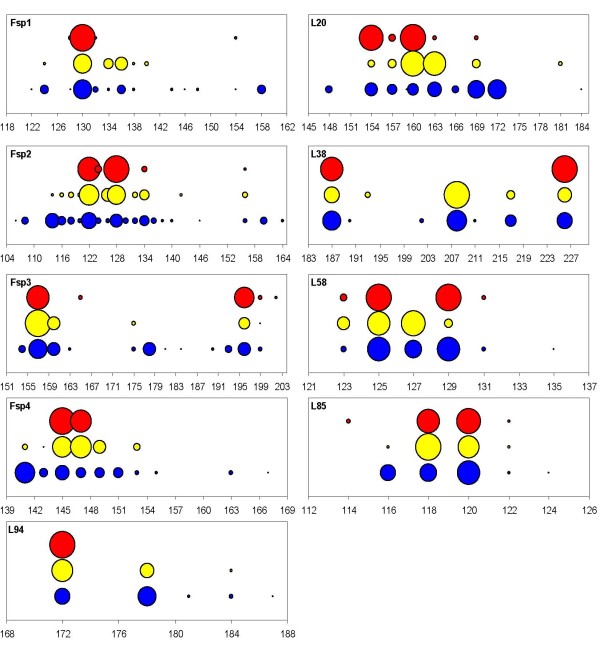
Allele frequency distribution of microsatellite loci. Each circle represents an allele and its frequency is proportional to the size of the corresponding circle (red: F. radicans, yellow: F. vesiculosus in Öregrund, SW Gulf of Bothnia; blue: F. vesiculosus in all other populations).